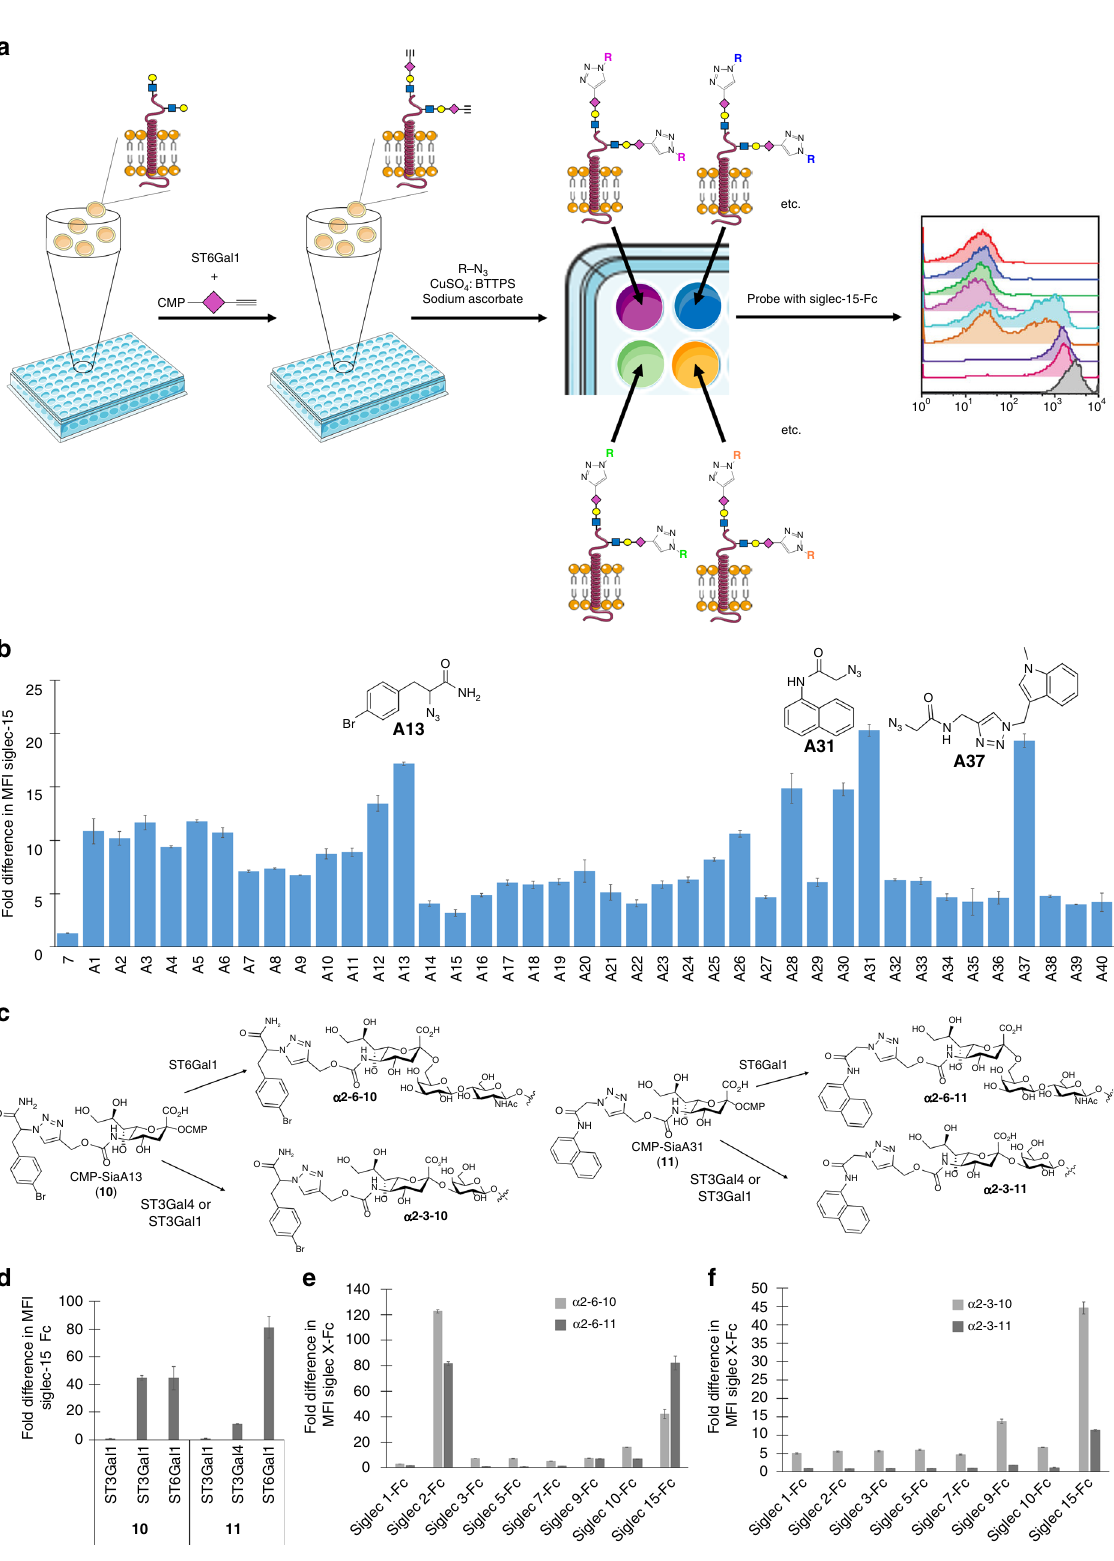
R–N 3 CuSO 4 : BTTPS Sodium